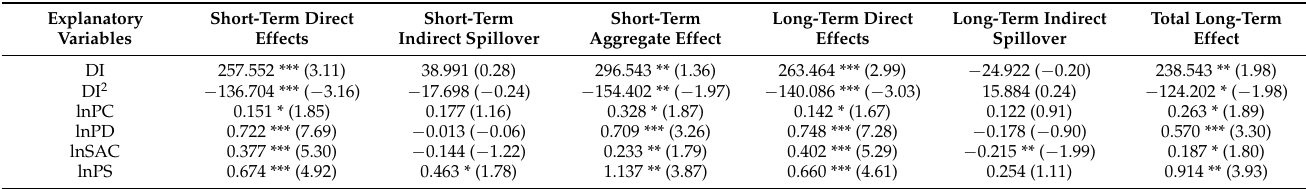
Table 8. Spatial effect decomposition of the DSDM model.